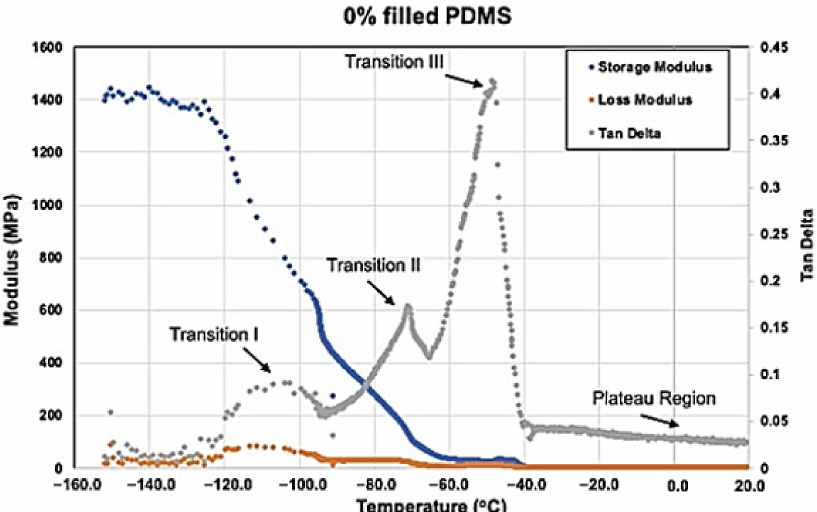
Figure 16. Storage Modulus, Loss Modulus, And Tan Delta Curves For 0% Filled PDMS From − 150 ◦ C To +20 ◦ C. (Transition I not labeled).